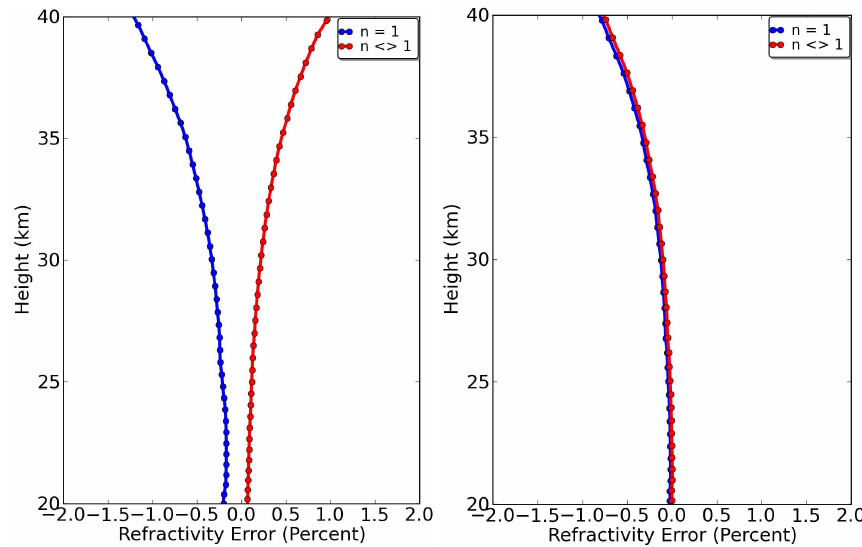
Fig. 13. Left panel: refractivity error assuming unity refractive index at the receiver, versus using the actual refractivity given by the GAIM electron density estimate, for the CHAMP raypath geometry. Right panel: same as the left panel but for the COSMIC raypath